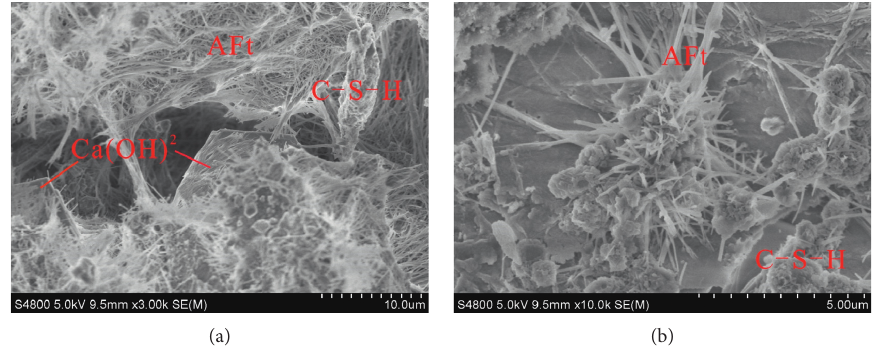
Figure 12: Micrograph of the bond interface between new and old